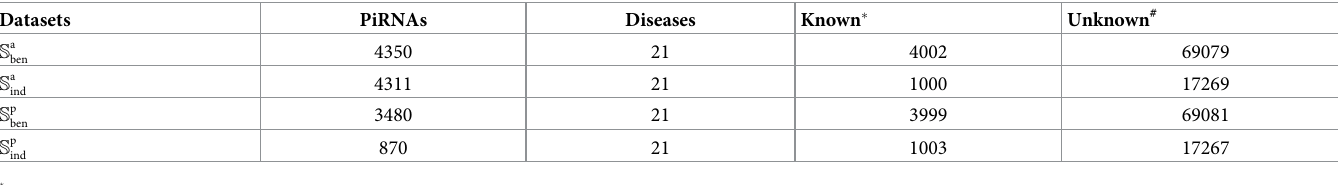
� The associations between piRNAs and diseases have been validated by experiments # The associations between piRNAs and diseases without experiment